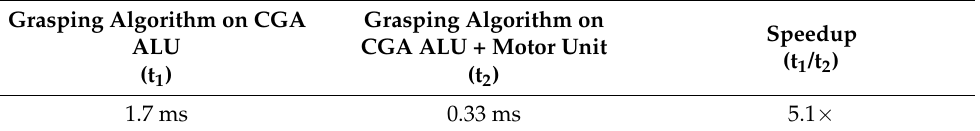
Table 12. Grasping algorithm execution times on CGA ALU and on CGA ALU + motor unit and related speedup.